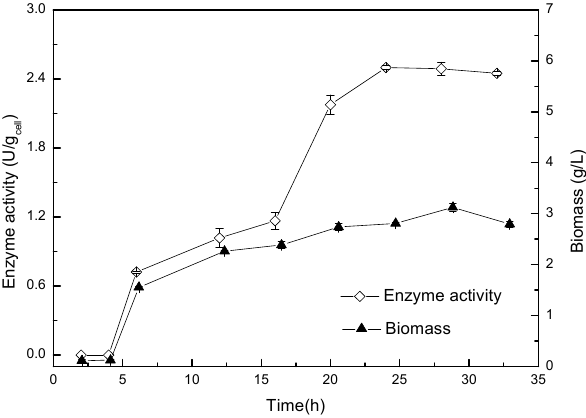
Figure 3. Curves of growth and enzyme production for Acinetobacter sp. ZJPH1806.